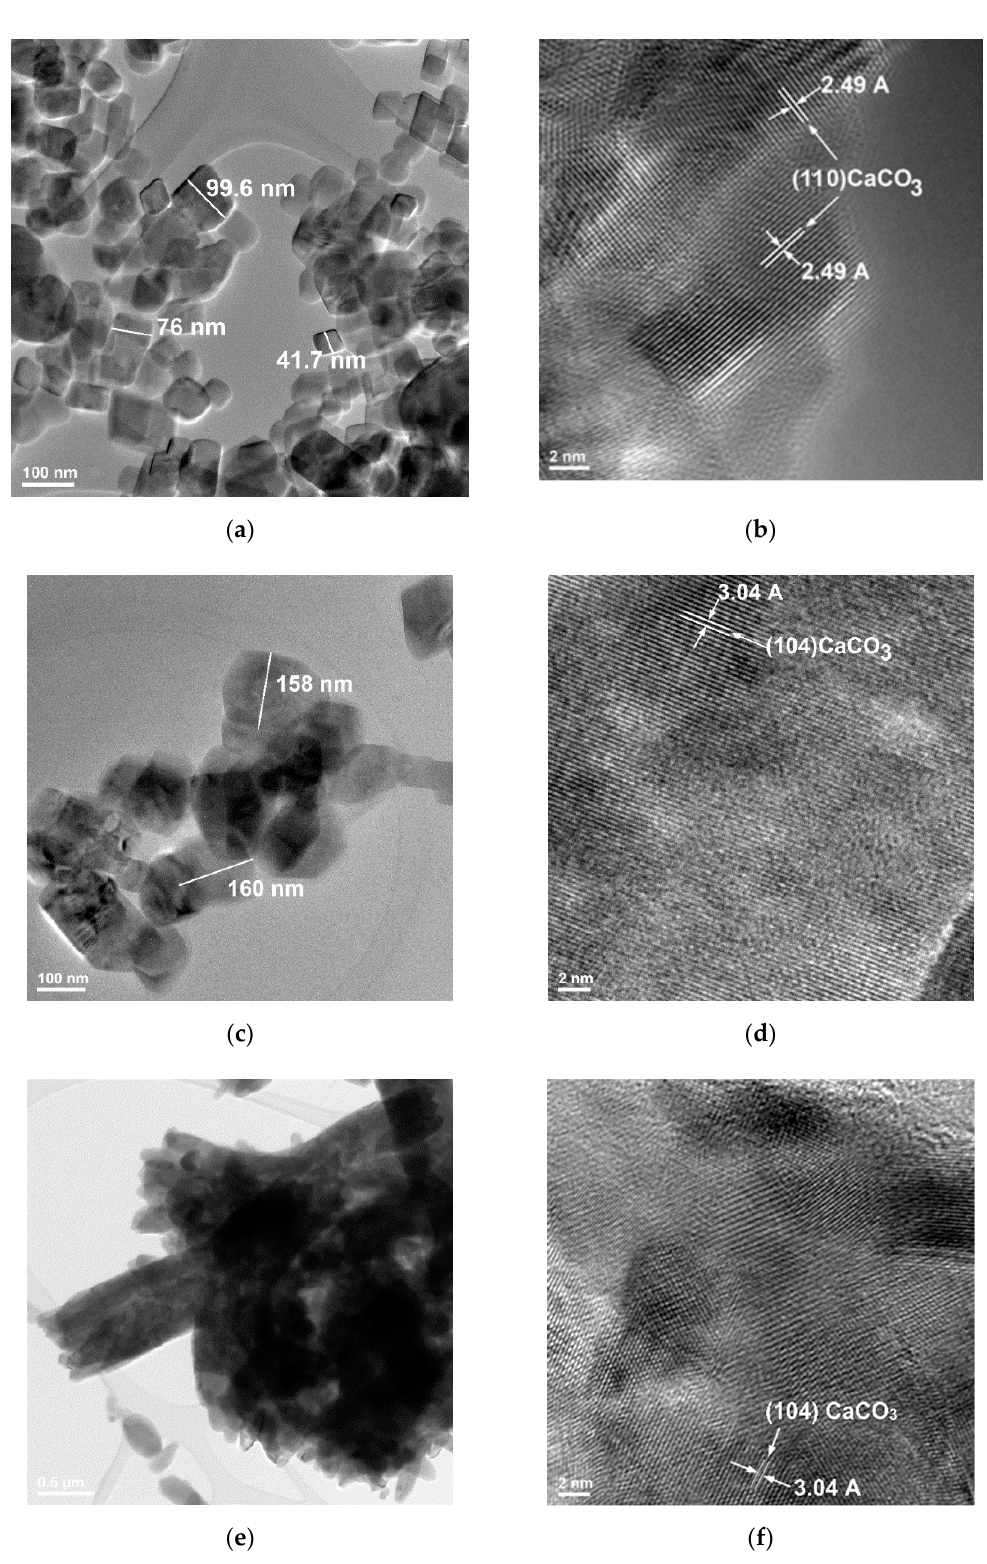
Figure 5. Transmission electron microscopy ( TEM) ( a , c , e ) and HRTM ( b , d , f ) images of dried powders CC0.5 ( a , b ), CC3.7 ( c , d ) and CC7.4 ( e , f ). The values of water for standard consistency of pastes decrease (with respect to ref- erence—PC paste) with the increase of limestone filler (L) content (Figure 6a). Yahia et al.